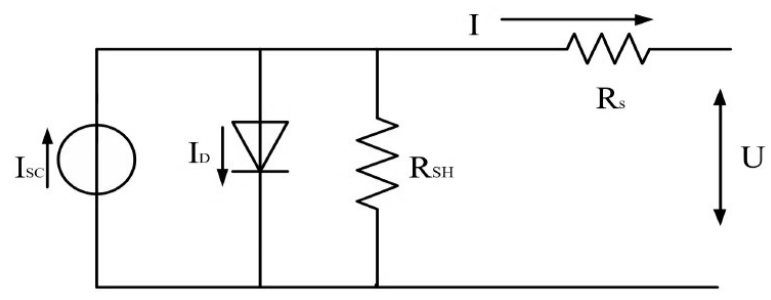
Figure 2. The physical approximate equivalent model of photovoltaic